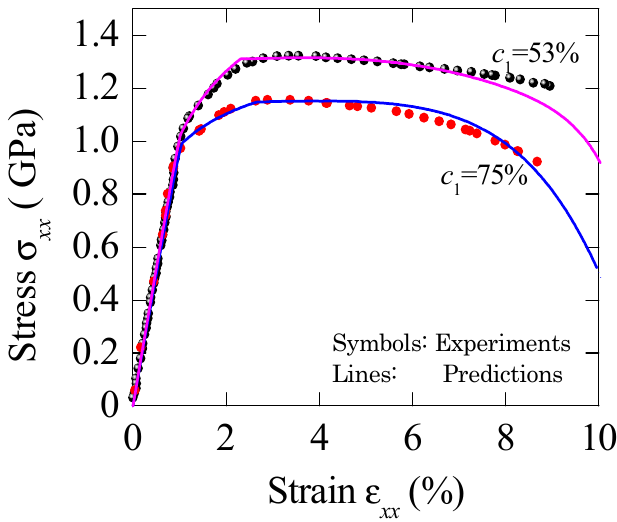
Figure 4. Comparisons of the macroscopic stress–strain relation between the prediction and experiments for BMGCs with different particle concentrations [20]. ε 0 = 0.11 and m = 8 are adopted in the computation.